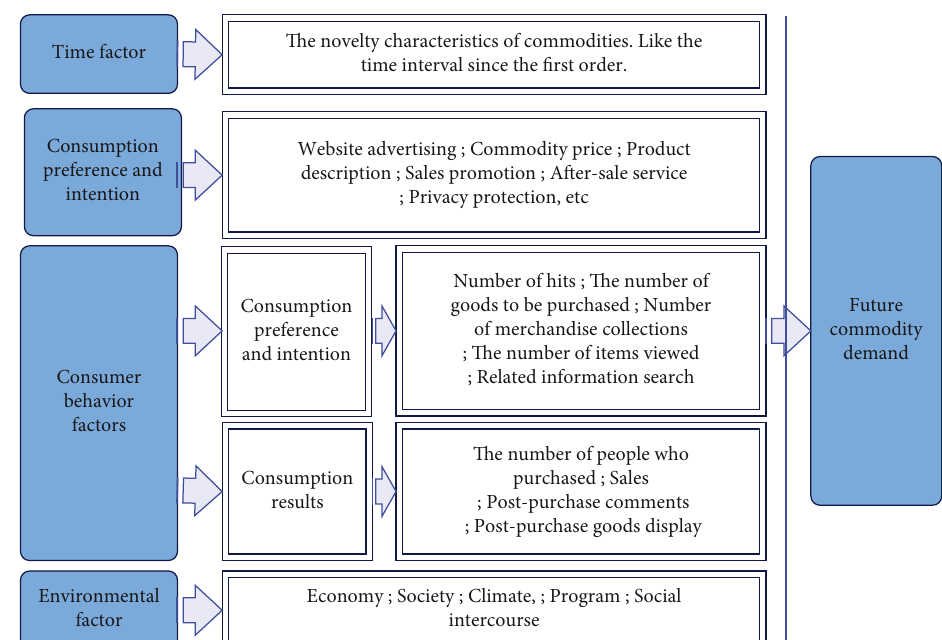
Figure 5: Influencing factors of demand amount of e-commerce goods.